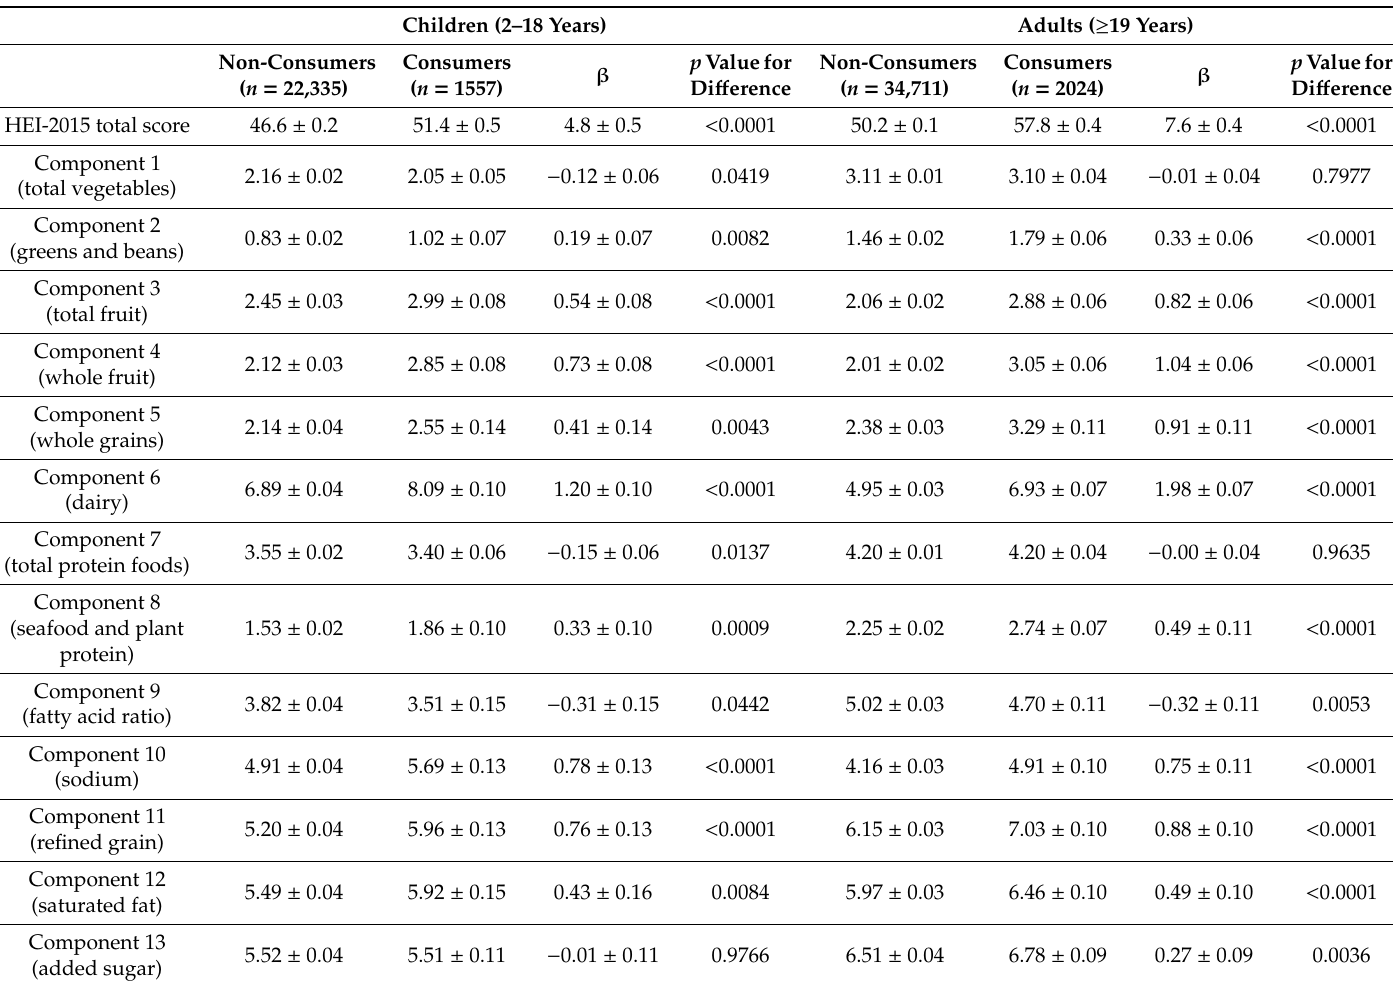
Table 4. Healthy Eating Index (HEI)-2015 scores for children and adult yogurt consumers and non-consumers. (NHANES 2001–2016, gender combined